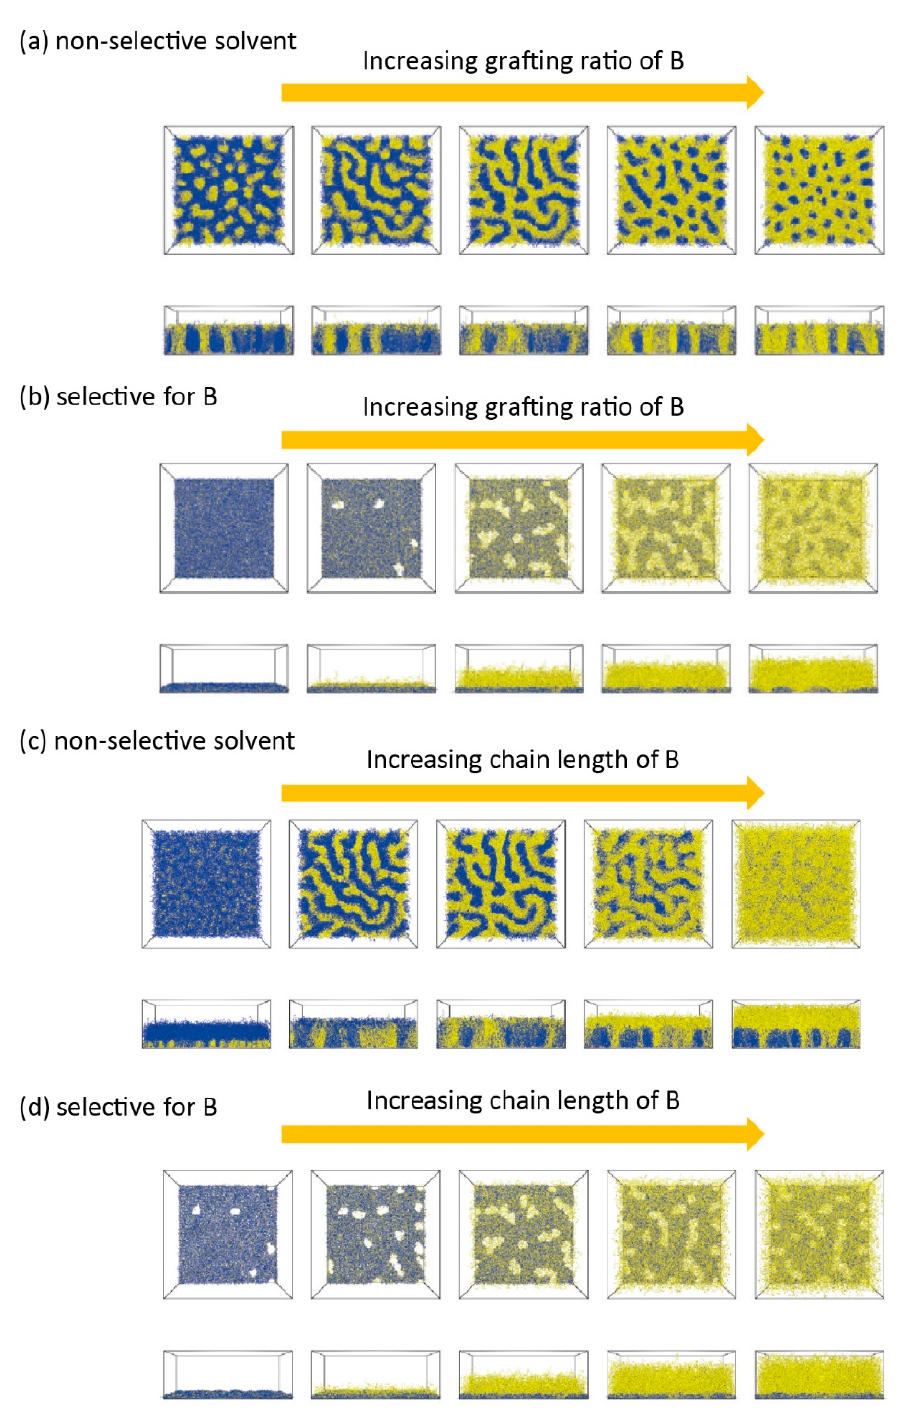
Figure 4. Simulation results on mixed polymer brushes (MPBs) composed of two incompatible polymers A (blue) and B (yellow). Top view and side view of MPBs with increasing grafting density of B and fixed grafting density of A in ( a ) non-selective good solvent and ( b ) selective solvent for B. The middle images represent equal grafting ratios of two components. Top view and side view of MPBs with increasing chain length of B and fixed chain length of A in ( c ) non-selective good solvent and ( d ) selective solvent for B. The middle images represent equal chain lengths of two components. (Reproduced with permission from Reference [150], Copyright 2009, American Chemical Society).